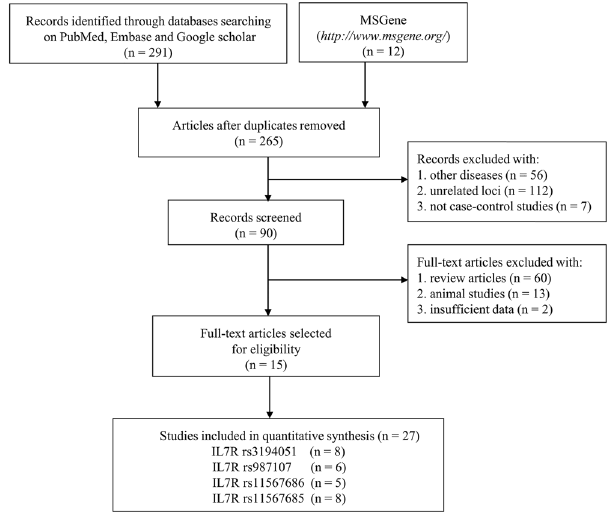
Figure 1. Flow diagram of the process used to select eligible